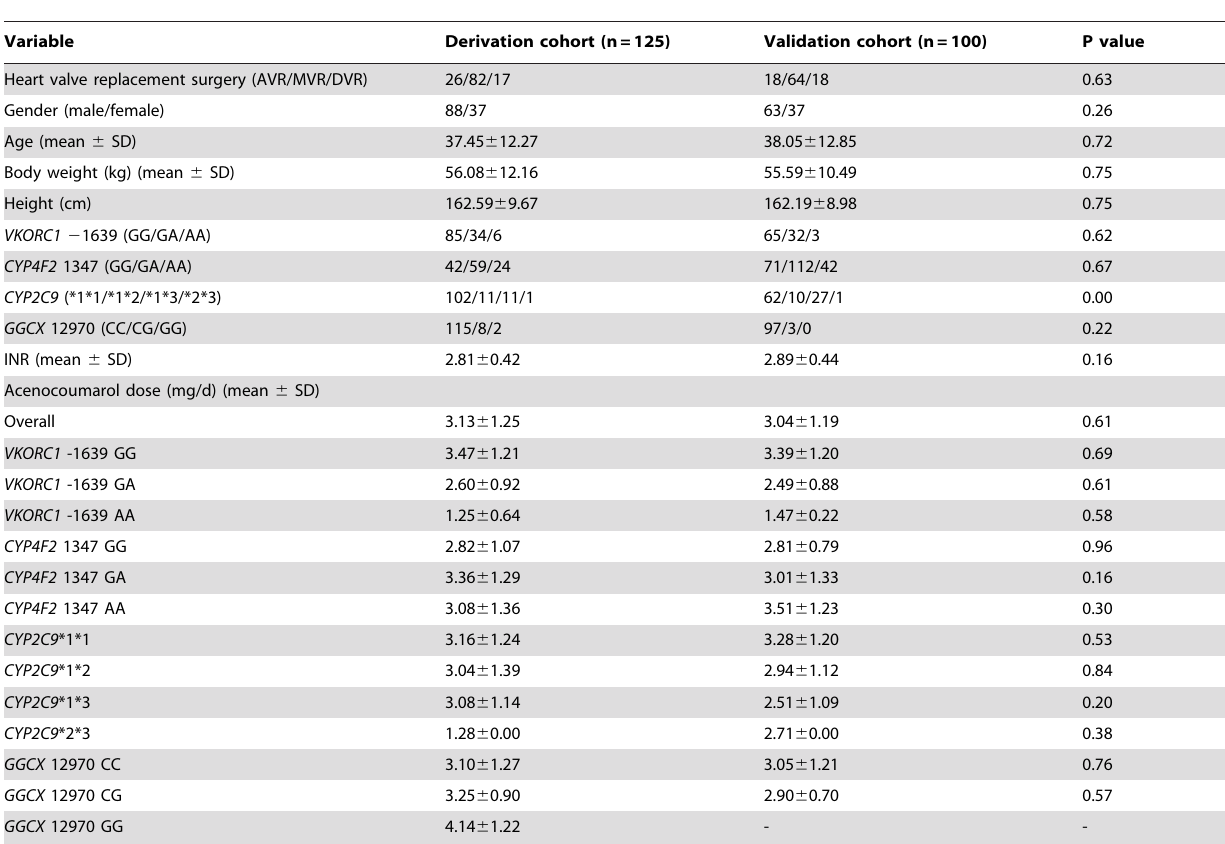
Table 1. Patient characteristics in derivation and validation cohorts.